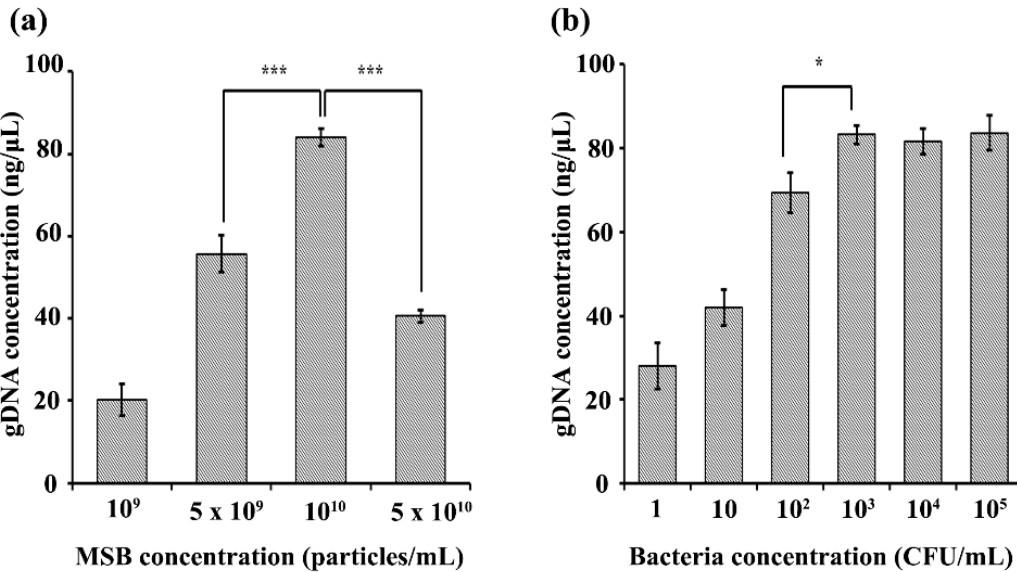
Figure 3. Effect of MSB and bacteria concentrations on DNA purification on the 3DpmFD: ( a ) gDNA concentration with different concentrations (10 9 –5 × 10 10 particles/mL) of MSBs for 10 3 CFU/mL of E. coli O157:H7; ( b ) gDNA concentration with different concentrations (1–10 5 CFU/mL) of E. coli O157:H7 using 10 10 particles/mL of MSBs *: p < 0.05, ***: p < 0.001. Student t -test. Sample number = 3.